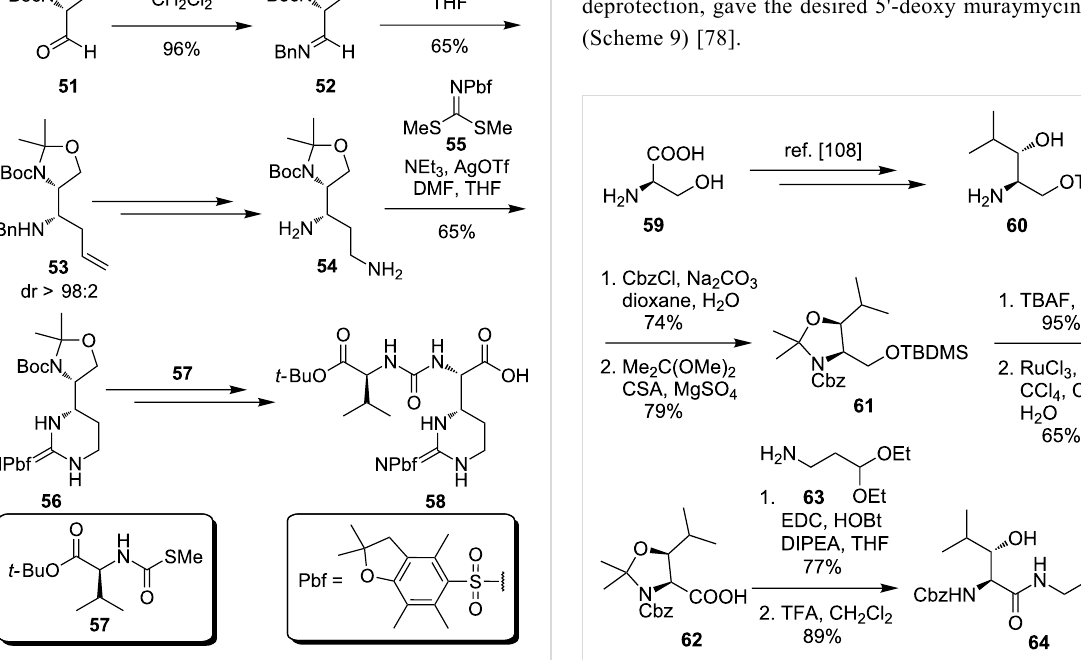
deprotection and peptide coupling with the epicapreomycidine- containing urea dipeptide 58 , followed by acidic global deprotection, gave the desired 5'-deoxy muraymycin C4 ( 65 ) (Scheme 9)